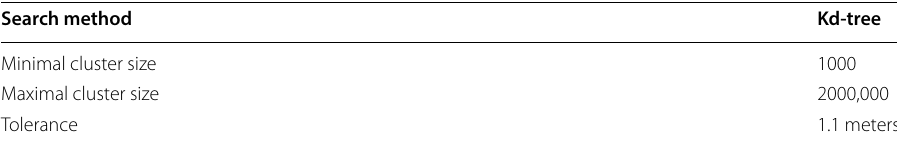
Table 3 Euclidean clustering parameters Search